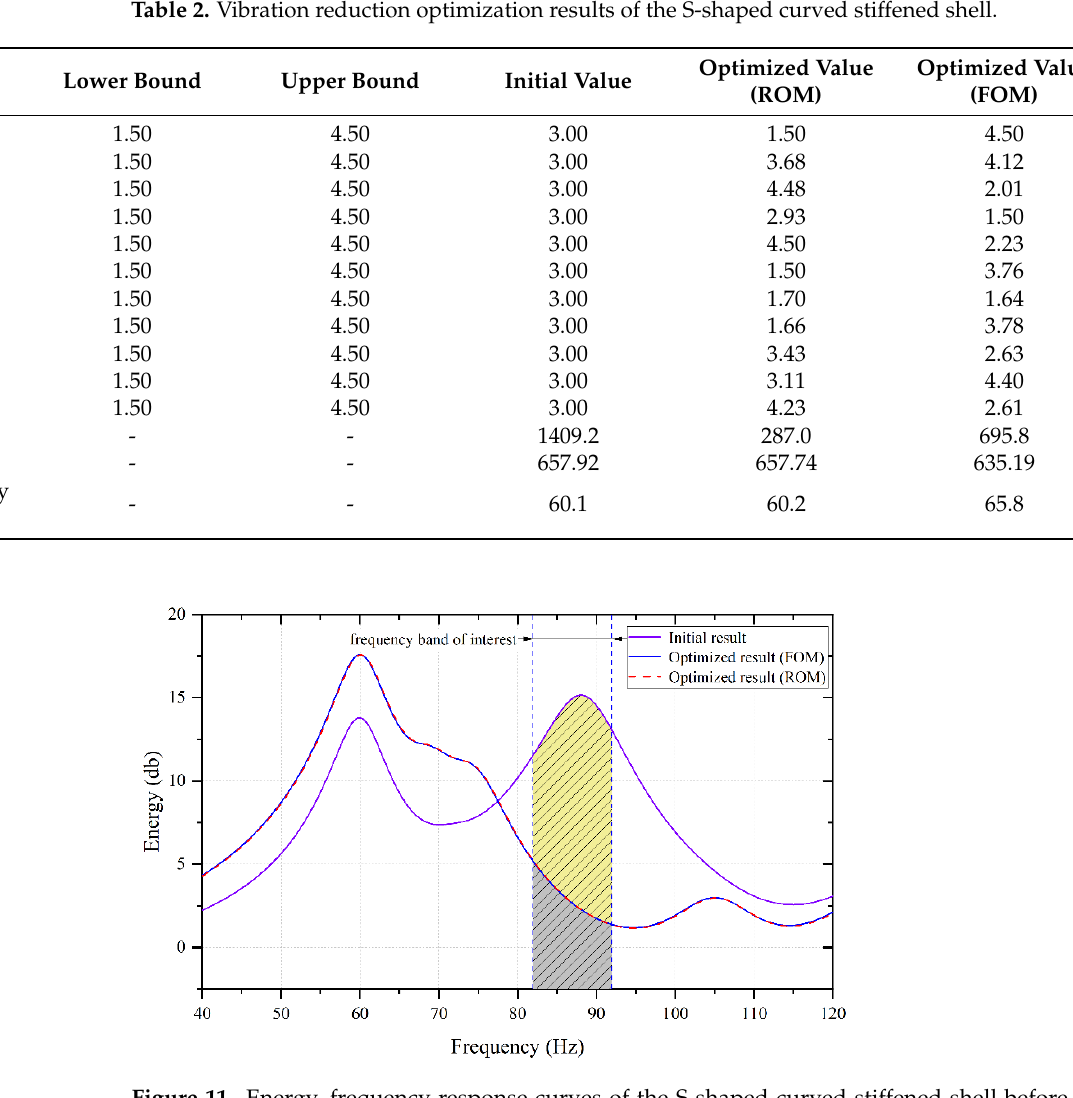
Figure 11. Energy – frequency response curves of the S-shaped curved stiffened shell before and after Figure 11. Energy–frequency response curves of the S-shaped curved stiffened shell before and optimizations. after